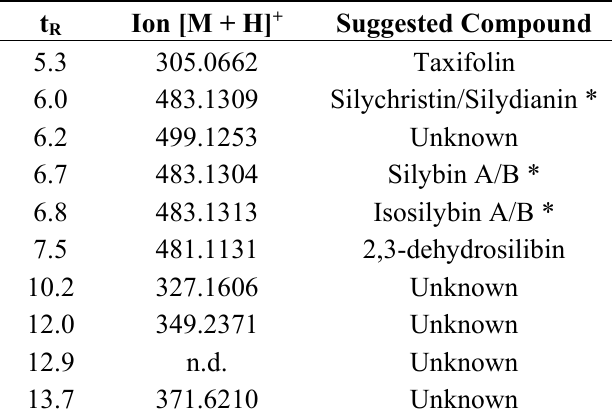
Figure A2. ID_25. Extract of Silybum marianum (L.) Gaertn. Table A4. Dereplication results for